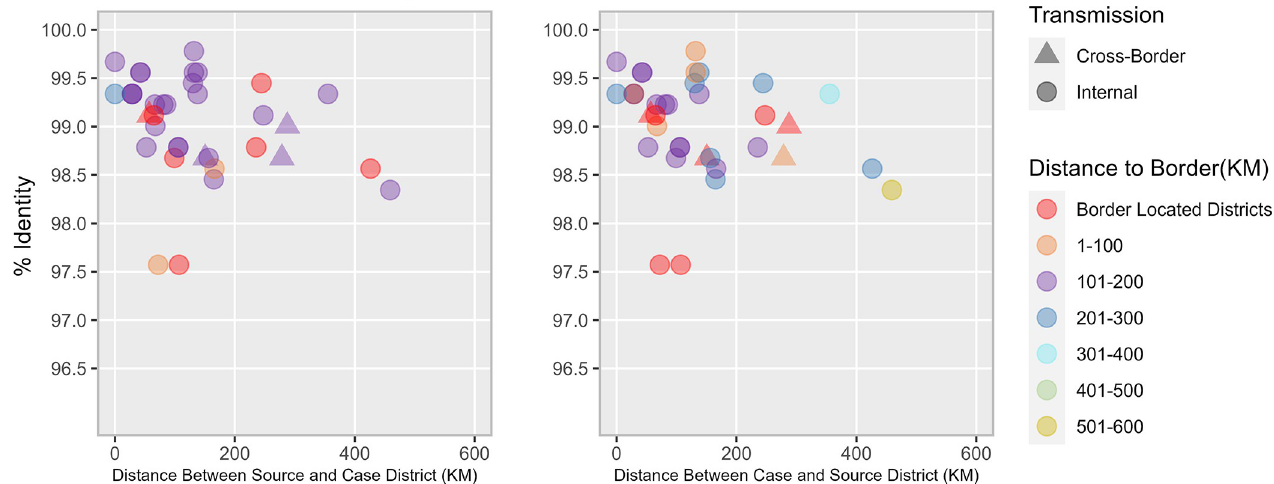
Fig 4. Scatterplot depicting A. nucleotide sequence identity (y-axis) for source districts in relation to the distance from its case district (x-axis) and distance from the border (color-coded) and B. nucleotide sequence identity (y-axis) for case districts in relation to the distance from its source district (x-axis) and distance from the border (color-coded) categorized under cluster